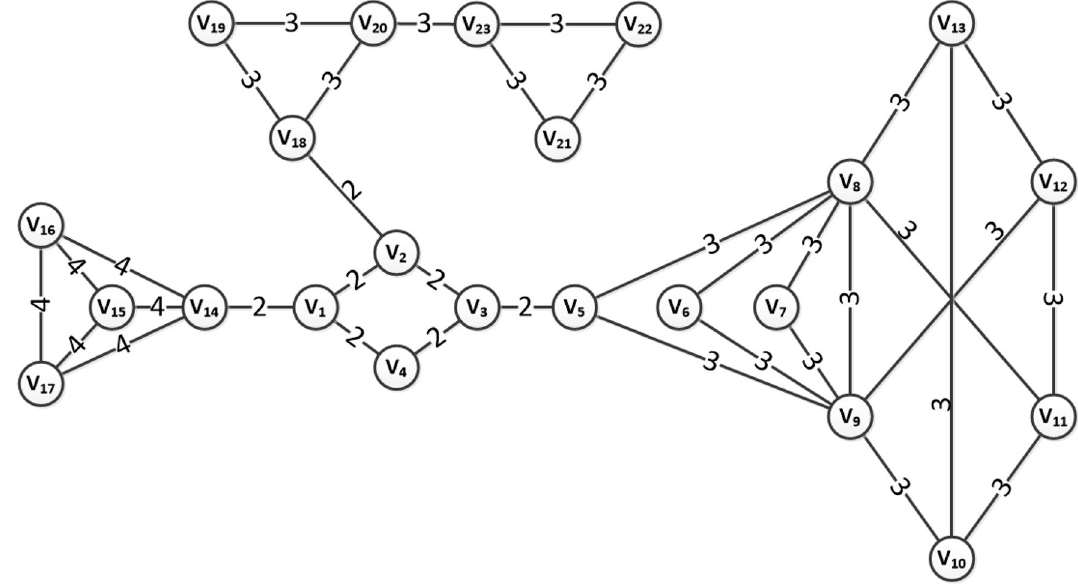
Fig. 5 The ct ( e ) in graph G where a ¼ 1